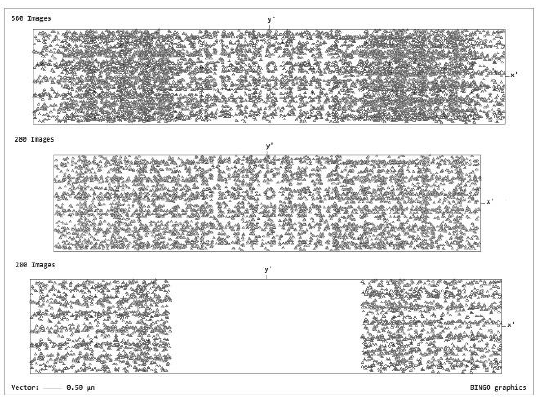
Fig. 6b : Result from the RGB Color Camera. All camera heads are on top and the slightly tilted camera heads on the left and right area of the image extend are on the bottom. The two cones from the center part of the frameare shown in the middle of the